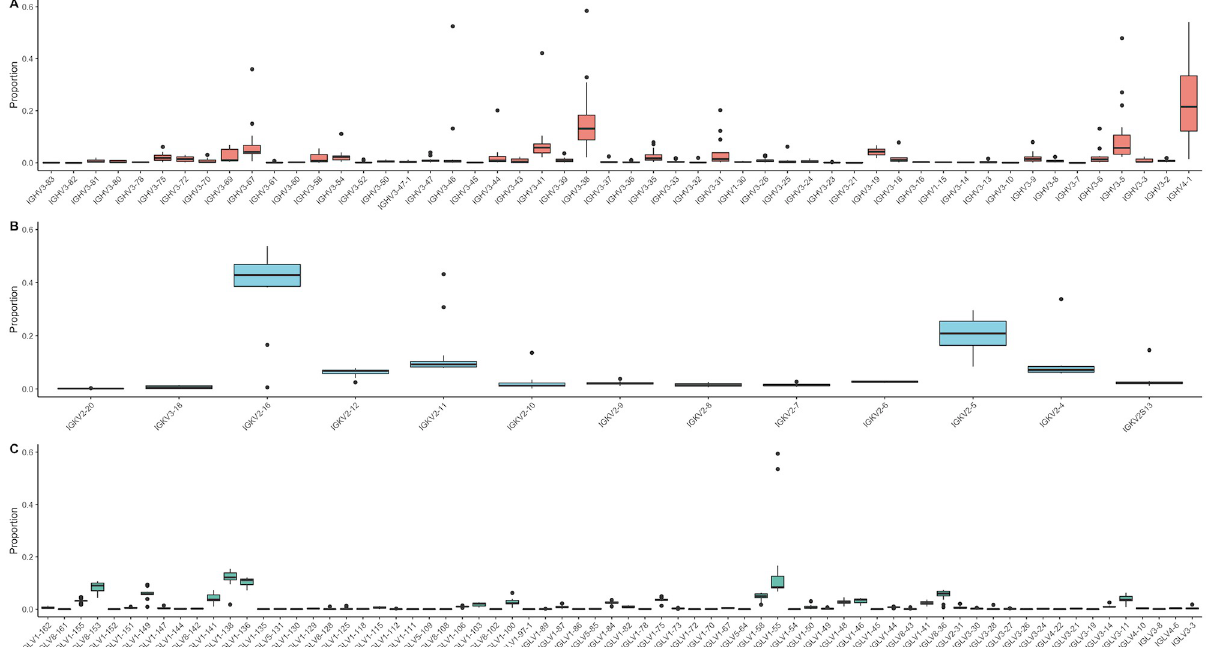
Fig 3. V gene usage. (A) IGHV. (B) IGKV. (C) IGLV. Genes are in locus order from left to right where the constant region(s) would be on the right hand end of the figure (i.e. IGHV3-83 is the most C-distal and IGHV4-1 the most C-proximal